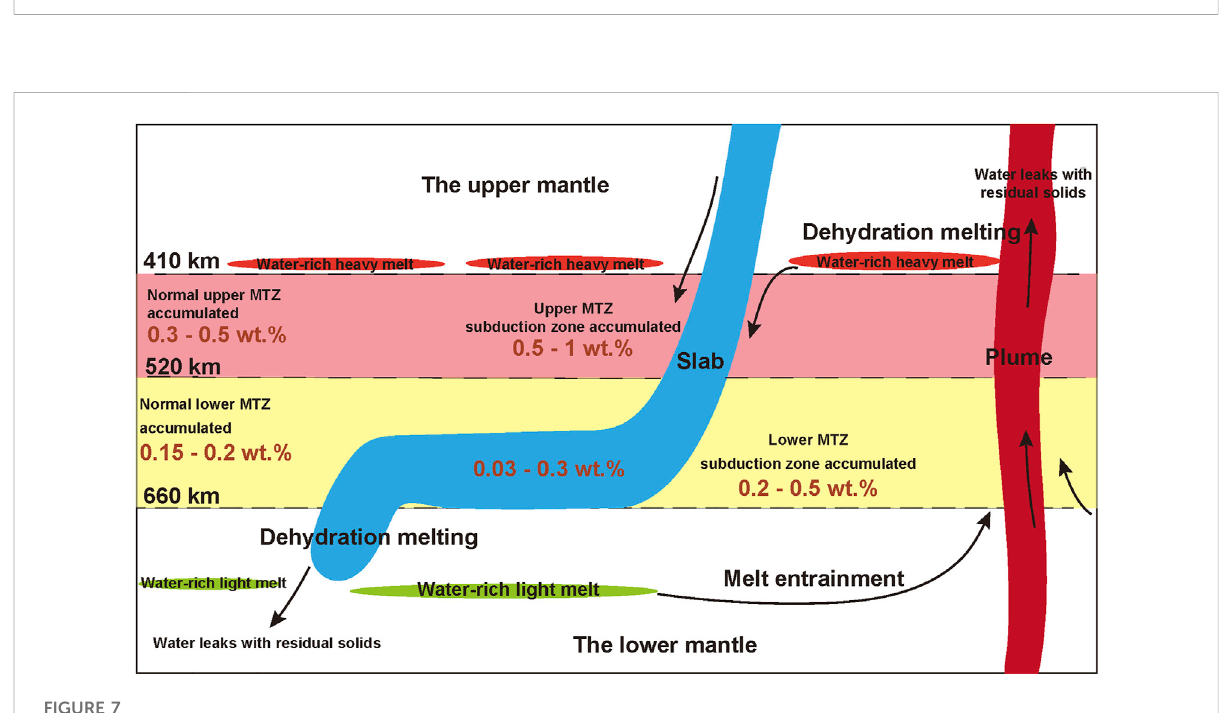
FIGURE 7 Schematic diagram for the water circulation in the